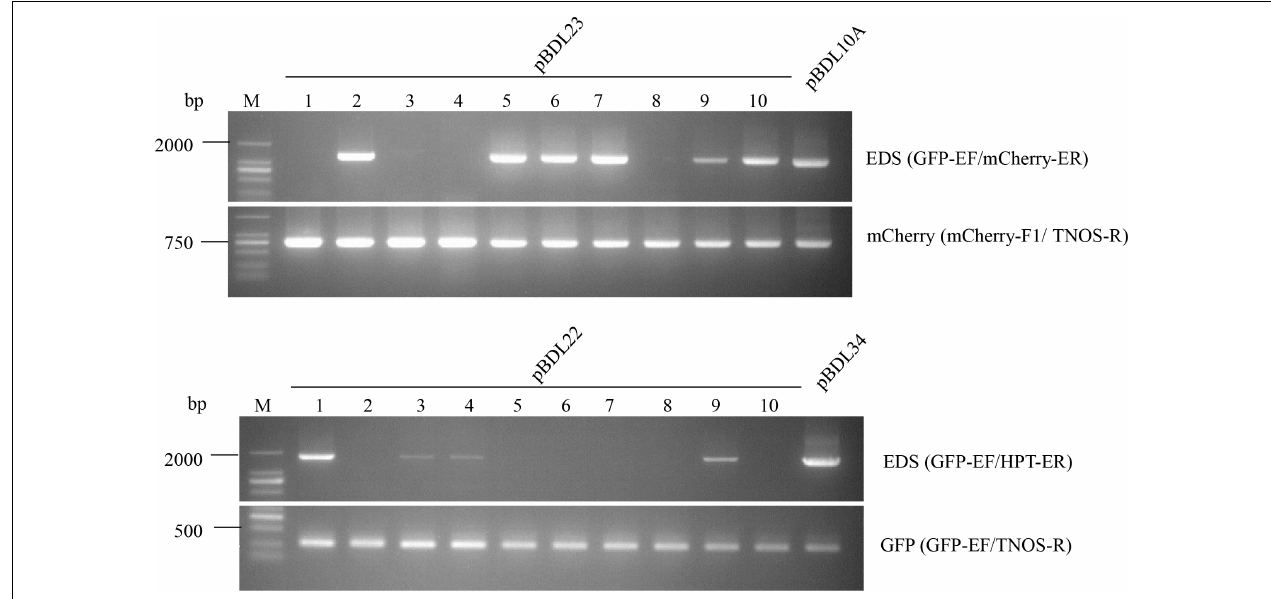
FIGURE 3 | PCR of the Ds empty donor site (EDS), mCherry, and GFP sequences in T0 rice plants transformed with pBDL23 and pBDL22. Ten pBDL23- or pBDL22-transformed T0 rice plants (1–10) were tested. Ds excision in T0 plants was monitored by the EDS bands. pBDL10A and pBDL34 are the progenitor vectors of pBDL23 and pBDL22 before a Ds element was inserted into the Sac I restriction site (see the section “Materials and Methods”), and were used as controls in EDS-PCR for the pBDL23- and pBDL22-transformed plants, respectively. GFP-EF and mCherry-ER are primers specific to the sequences adjacent to Ds element in pBDL23. GFP-EF and HPT-ER are primers specific to the sequences adjacent to Ds element in pBDL22.